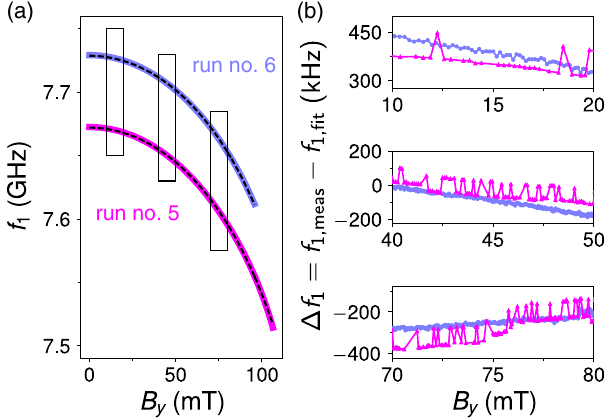
FIG. 14. Interactions with other mesoscopic systems. (a) Qubit transition frequency f 1 as a function of the applied in-plane magnetic field B measured in two different cooldowns. The y black dashed lines indicate fits to Eq. (G1). (b) Frequency difference Δ f 1 between the measured transition frequency f 1 and the fit result f 1 [see Eq. (G1)] in three different ; meas ; fit field ranges. On this scale, discrete jumps in the qubit frequency become visible for the data taken in run no. 5. The jumps remain qualitatively unchanged over a 150 MHz span covered by the qubit frequency versus B , and in neither of the runs did we y observe signatures of avoided level